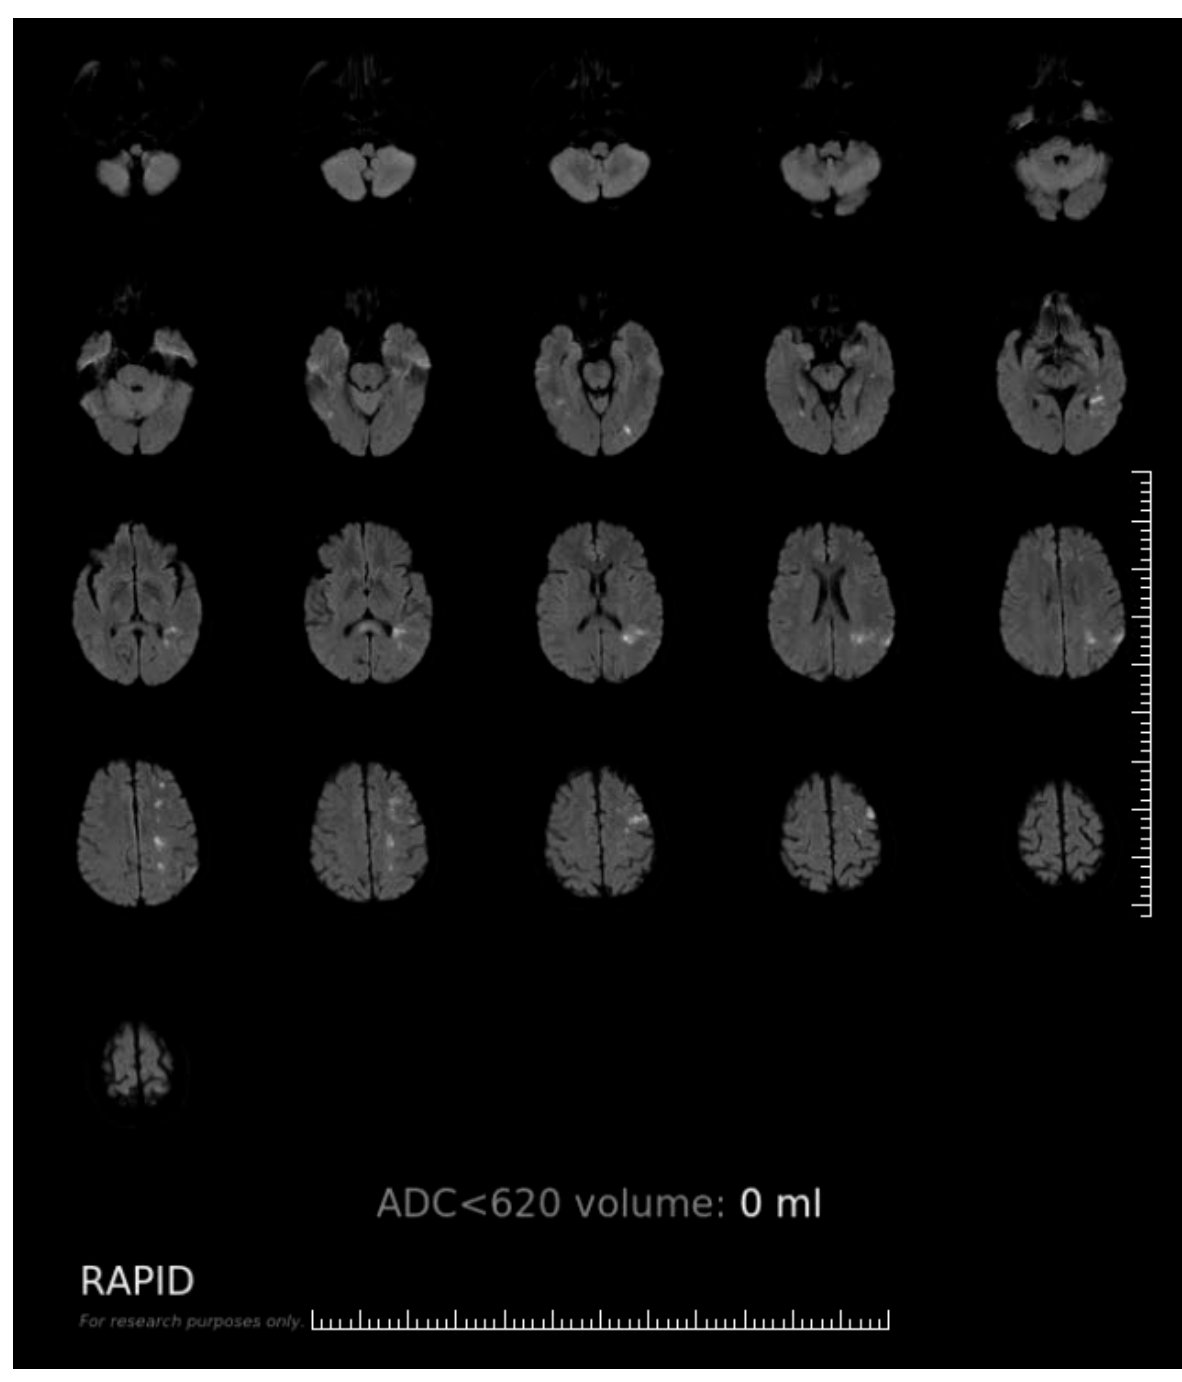
Figure A1. ADC map of a patient. Step 2: Calculating the hypoperfused